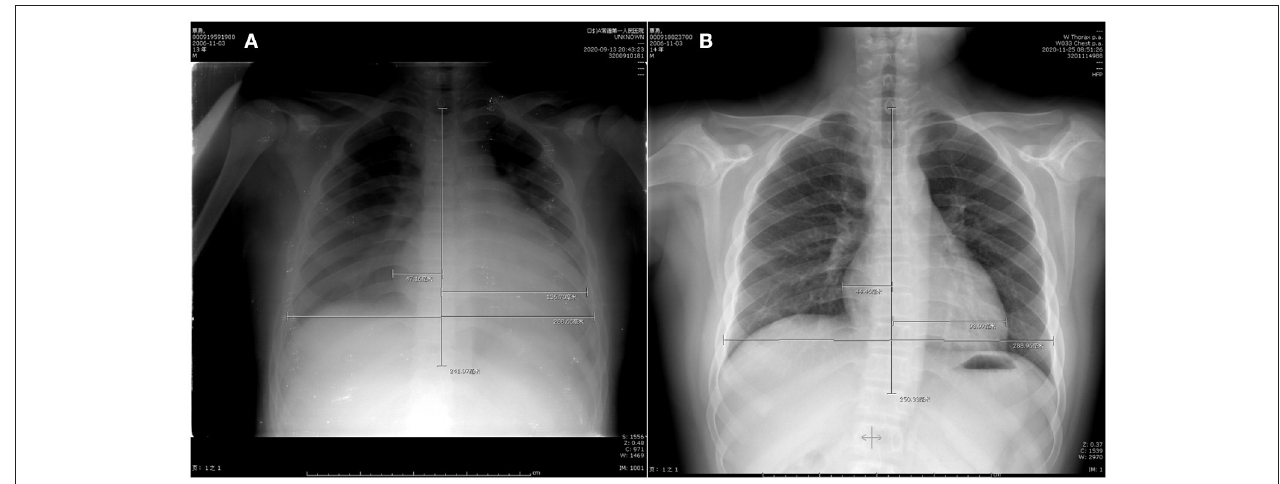
FIGURE 4 | Chest radiographa (A) before operation, cardio-thoracic ratio 0.64; (B) 2 months after operation, cardio-thoracic ratio 0.50.